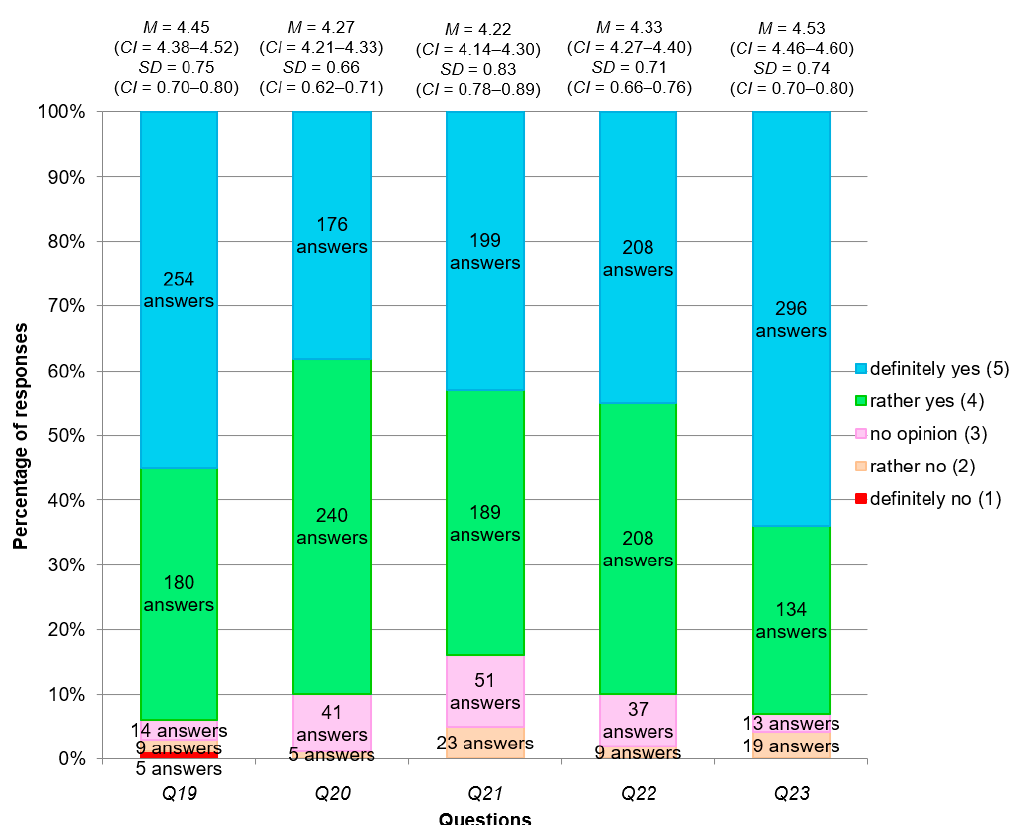
Figure 10. Assessment of economic factors influencing the choice of an alternative energy source for heating water in residential buildings ( M —average, SD —standard deviation, CI —confidence interval; questions numbers ( Q ) according to the Appendix A).